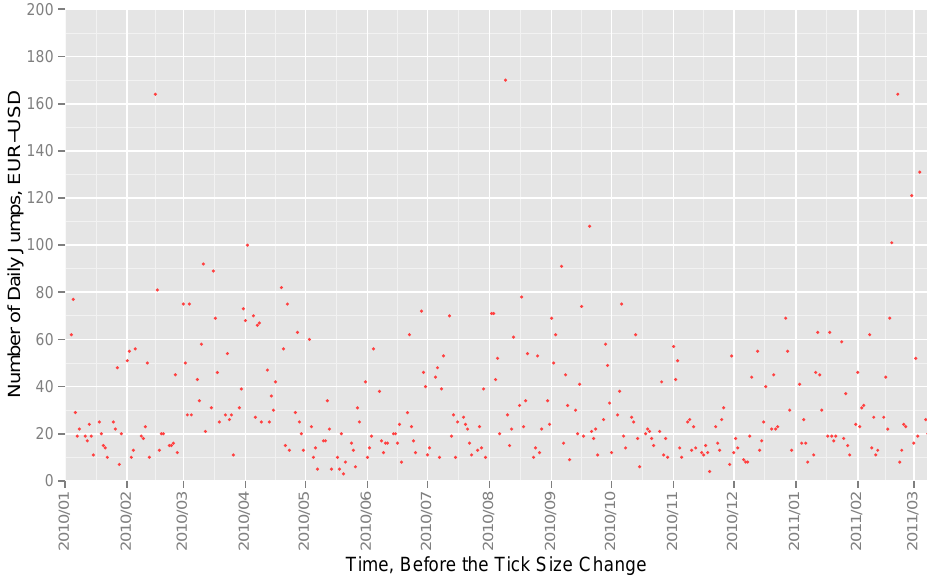
Figure 3. Daily Number of Jumps of EUR/USD, Before Tick Size Change.